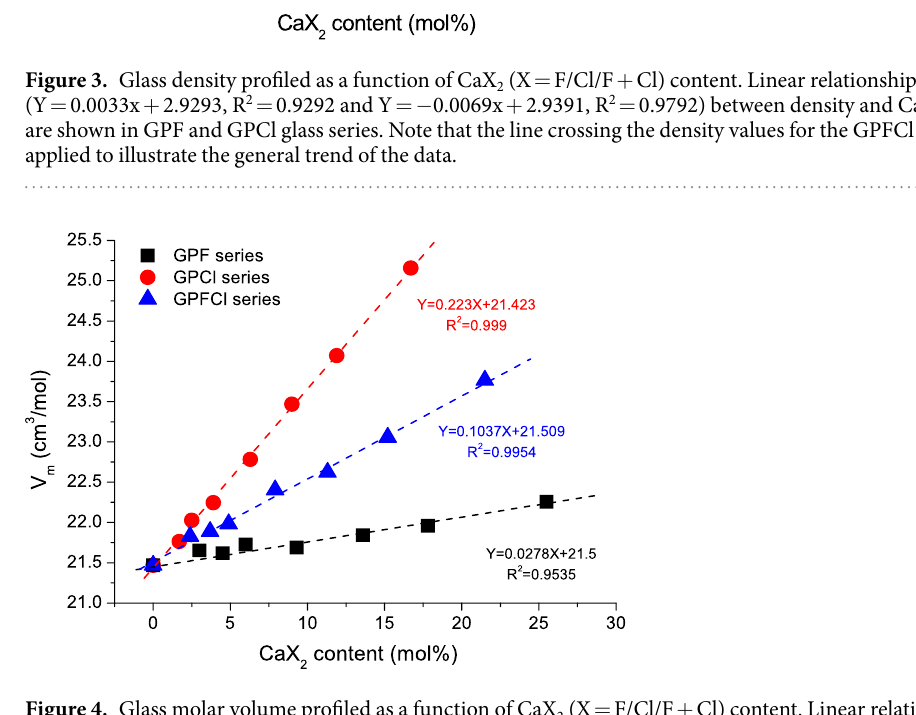
Figure 4. Glass molar volume profiled as a function of CaX 2 (X = F/Cl/F + Cl) content. Linear relationships (Y = 0.223 x + 2.21.423, R 2 = 0.999, Y = 0.1037 x + 21.509, R 2 = 0.9954 and Y = 0.00278 x + 21.5, R 2 = 0.9535) between density and CaX 2 content are shown as dotted lines in GPF, GPCl and GPFCl glass